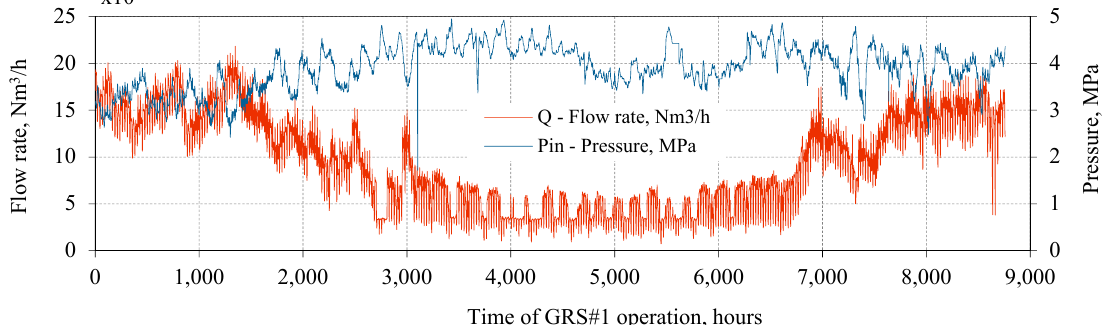
Figure 4. Natural gas flow and pressure at regulation stations GRS #1 (before expansion) over a period of one year.